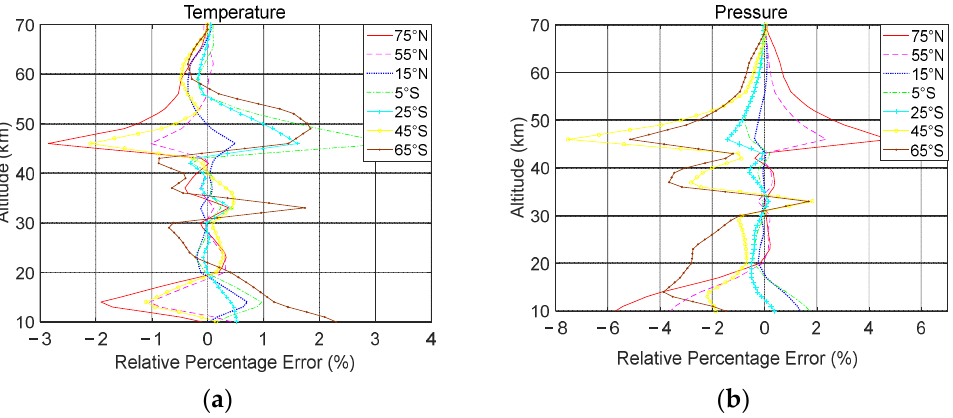
Figure 5. Ozone retrieval error caused by neutral density. ( a ) Pressure profiles at different latitudes; ( b ) temperature profiles at different latitudes.